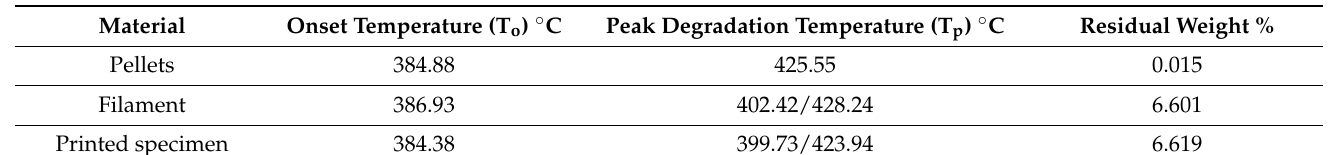
Table 3. Decomposition temperatures and residual weights of the PET pellets, extruded filament, and 3D-printed materials.